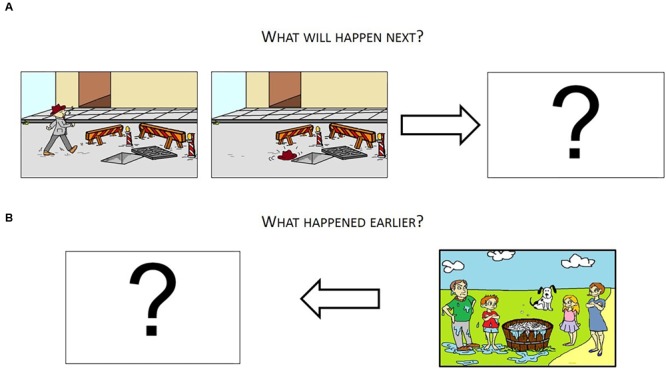
Cartoon stories designed to assess narrative production. (A) Shows future-generation condition (adapted from Pagni, 2011). (B) Shows past-generation condition (adapted from Ripamonti, 2013).